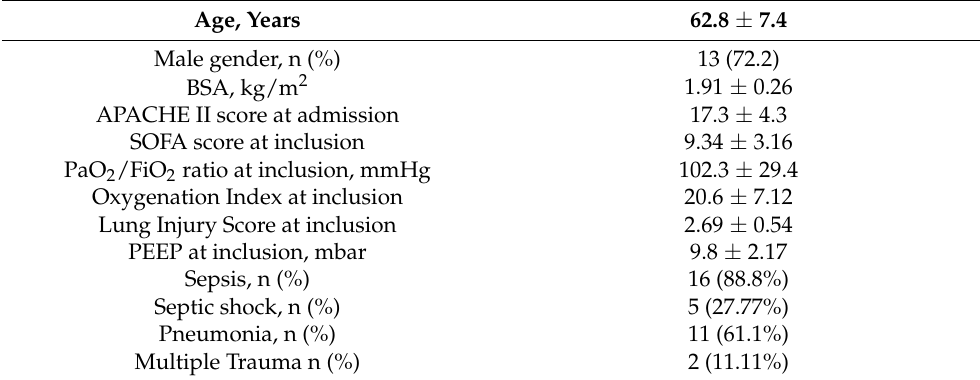
Table 1. Baseline characteristics of participants.